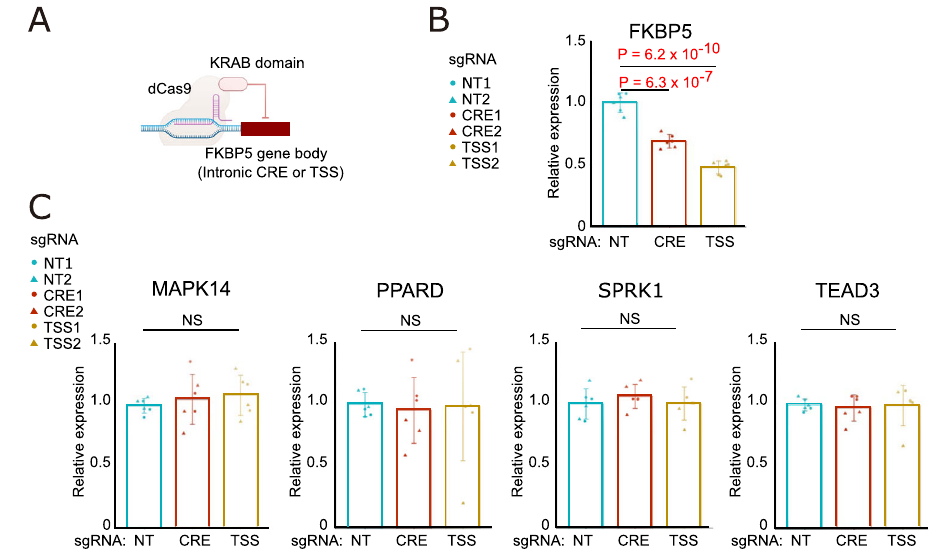
Fig.6|Knockdownof FKBP5 cis-regulatoryelementswithCRISPRinterference. A CRISPR interference diagram. dCas9-KRAB domain fusion protein and small guide RNAs (sgRNA) were used to target the TSS and a potential intronic CRE in the FKBP5 gene. Targeted regions are depicted as blue stars in the FKBP5 gene model diagram in Fig. 5E. sgRNA primers and region coordinates are provided in Supplementary Dataset 21. B , C Quantitative PCR of CRISPRi. RT and real-time PCR analysis of mRNAs for FKBP5 and surrounding genes ( MAPK14 , PPARD, SPRK1 and TEAD3 ) in primary renal proximal tubular